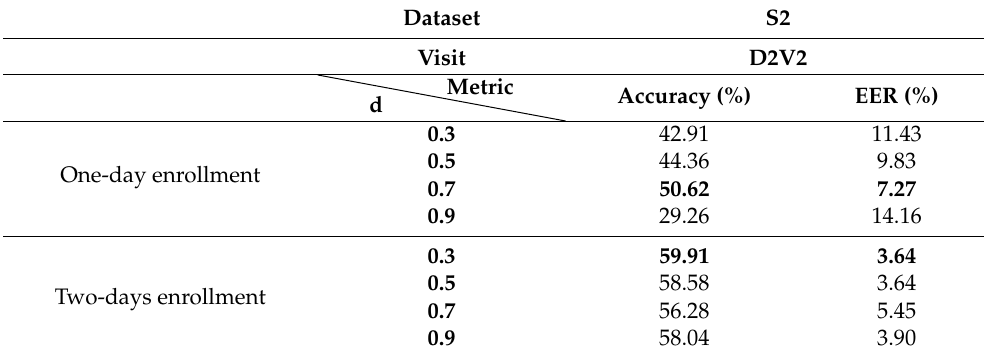
Table 7. Identification and verification results for scenario Ex. The best considered options for one-day and two-days enrollment are in bold